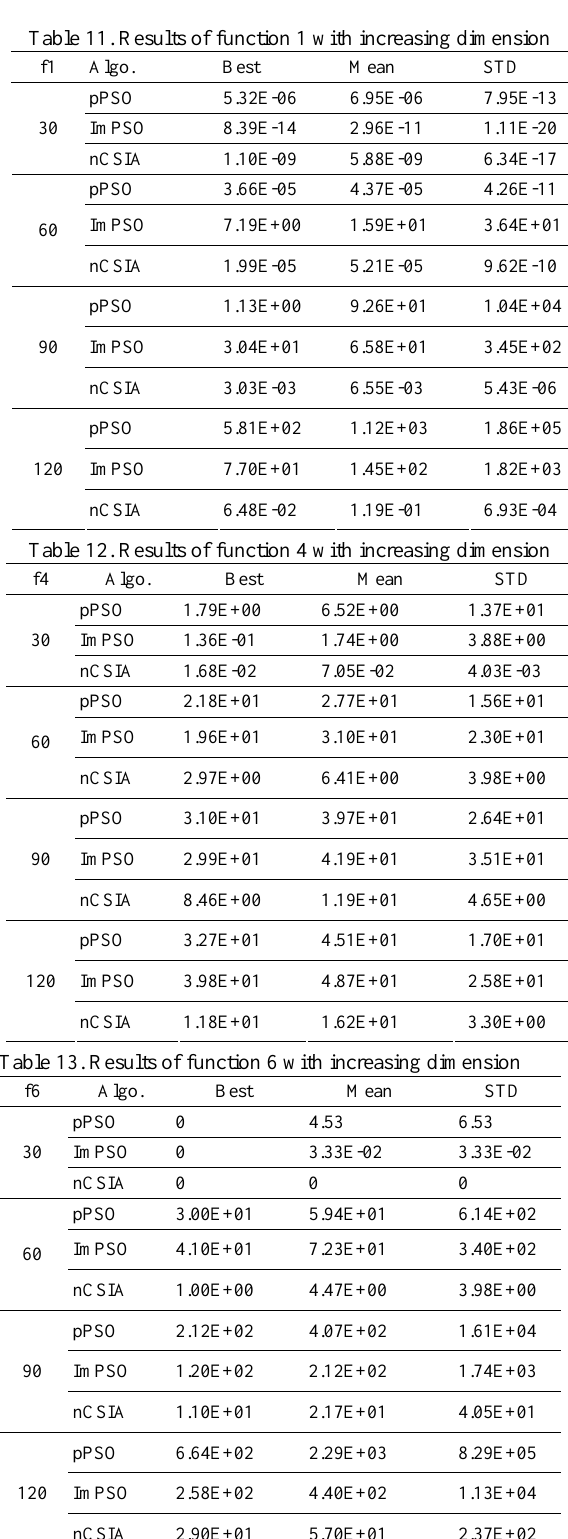
Table 8. Results of function 10 with expanding domain